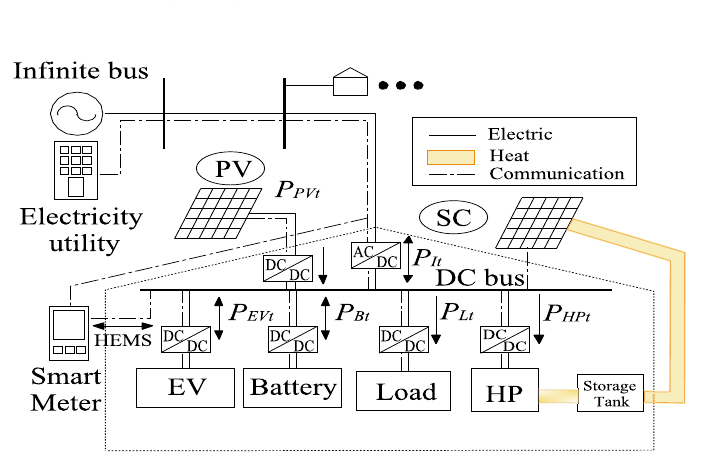
Figure 1. Smart home system model. EV, electric vehicle; HP, heat pump; PV, photovoltaic generation; SC, solar